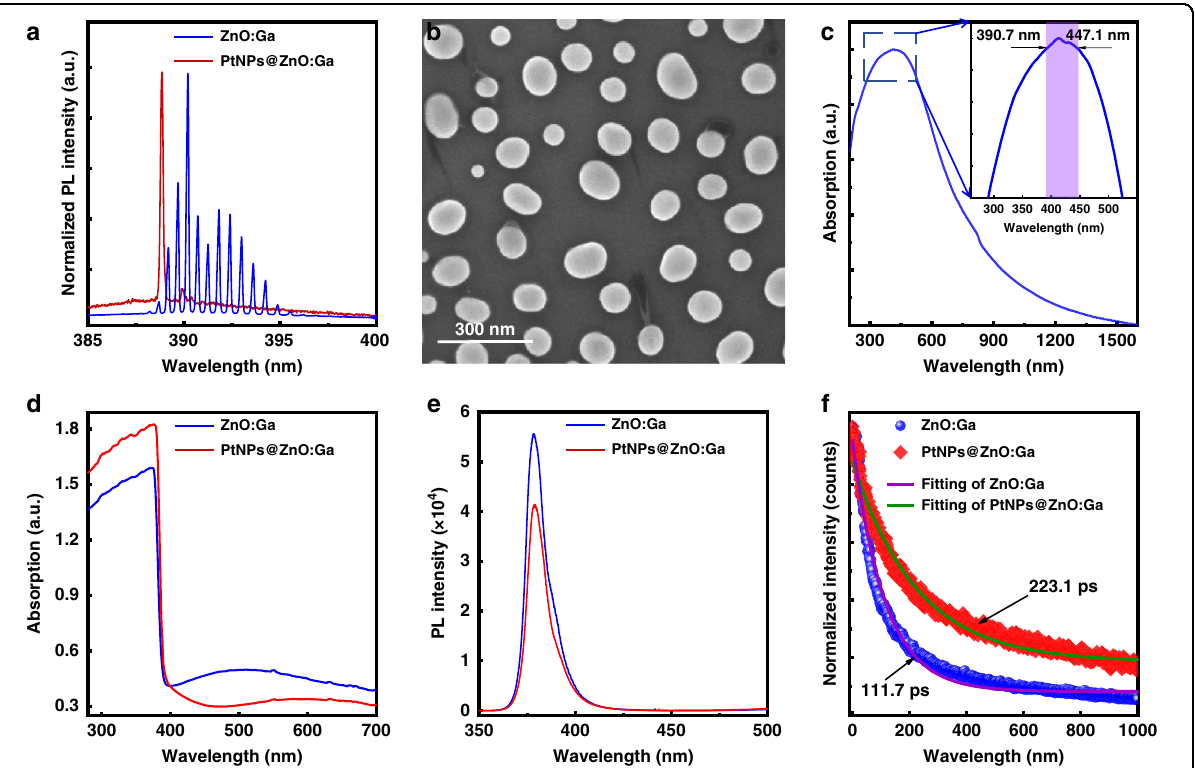
Fig. 5 The in fl uence of large size PtNPs on the optical properties and lasing features of a single ZnO:Ga MW. a Normalized lasing spectra of a single ZnO:Ga MW not decorated and decorated by PtNPs is given for a comparison. b SEM image of PtNPs prepared on a quartz substrate. c Normalized absorption spectrum of the as-prepared PtNPs. Inset: Enlarged absorption peak varying in the range of 390.7 ~ 447.1 nm. d Optical absorption spectra of a single ZnO:Ga MW and the same wire decorated by PtNPs. e PL spectra of a single ZnO:Ga MW not decorated and decorated by PtNPs. f Normalized TRPL spectra and exponential decay fi tting curves at a wavelength of 390 nm of a single ZnO:Ga MW before and after PtNPs